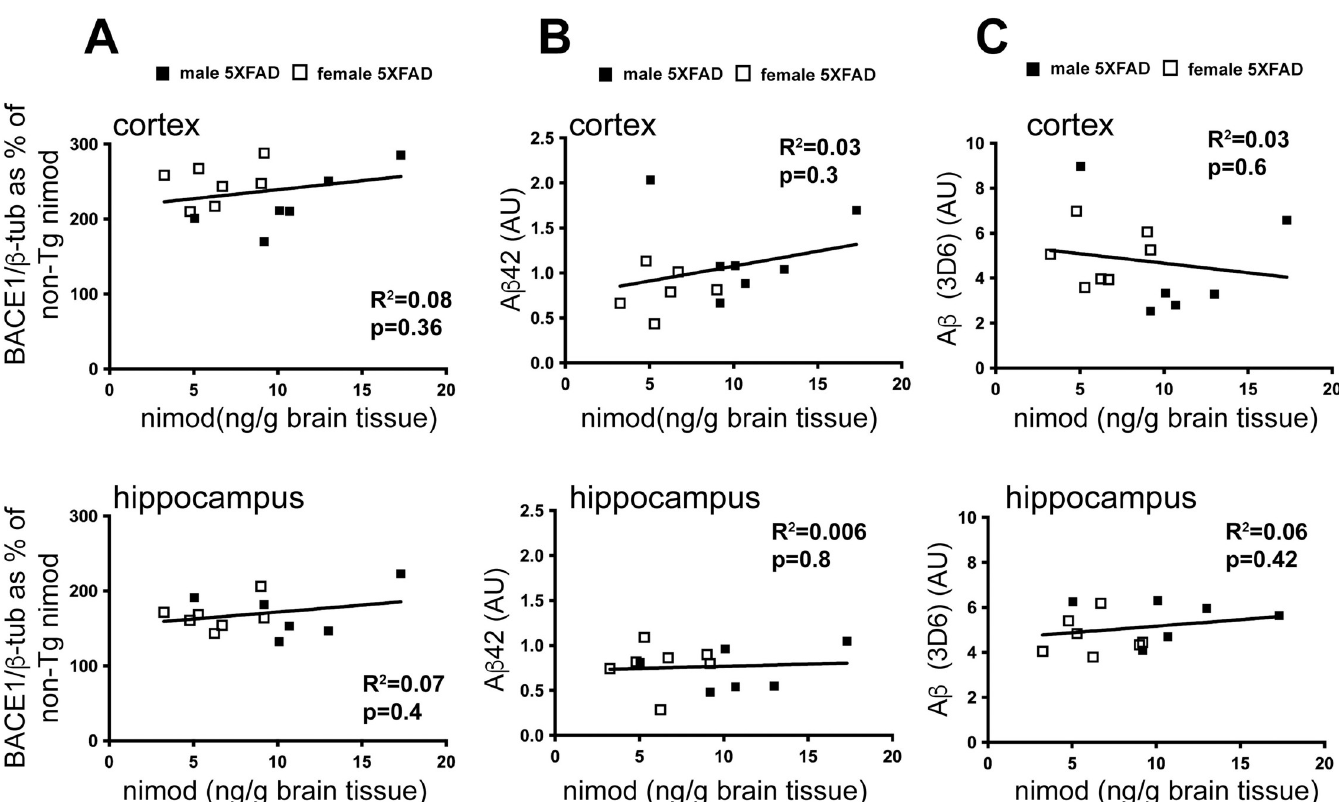
Fig 6. BACE1 and A β levels are not correlated with nimodipine levels in 5XFAD transgenic mice. ( A) BACE1 as measured by western blot (shown in Fig 2), does not correlate with nimodipine levels as measured by mass spectrometry in either cortex or hippocampus. (B) There is also no correlation between A β 42 levels and nimodipine concentration in the brain or (C) between A β and